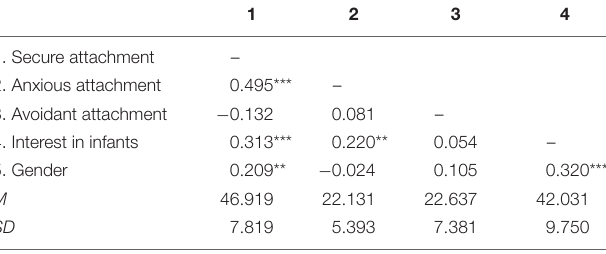
TABLE 1 | Descriptive statistics and correlations ( n =